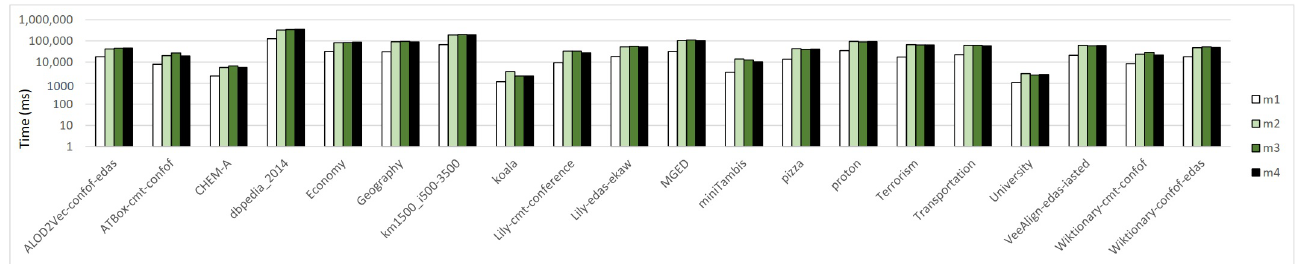
Figure 2. Time in milliseconds (y-axis) for each ontology to compute similarities for all axiom pairs in each ontology by using Cosine